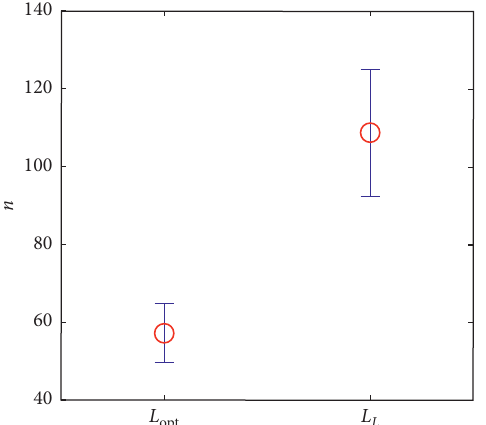
Figure 7: Variation of means of number of cells to visited in the ) and hTetro with a fixed size of L L error cases of P-hTetro (i.e., L opt bars. The error bars represent the standard error of mean. Table 3: Results of the t -test on number of cells to be visited. Robot